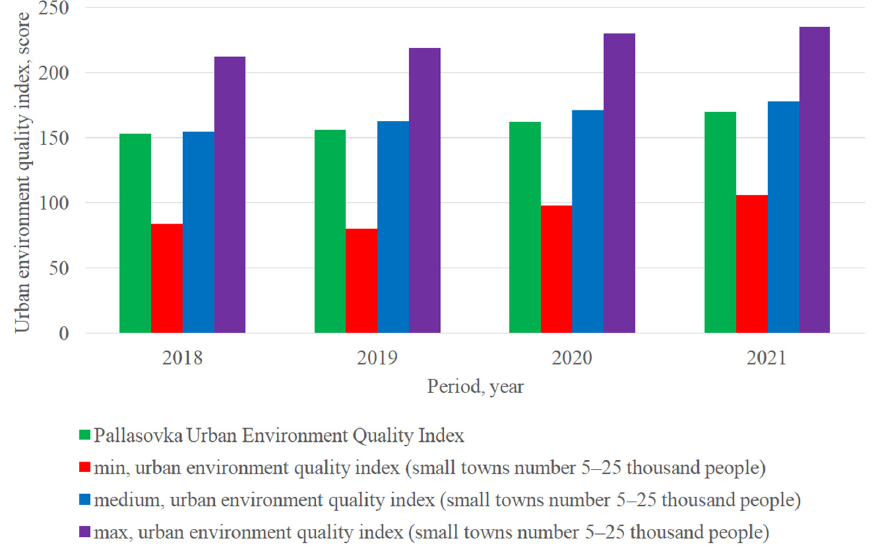
Figure 4. Urban environment quality index in Pallasovka, Volgograd Oblast, Russia.